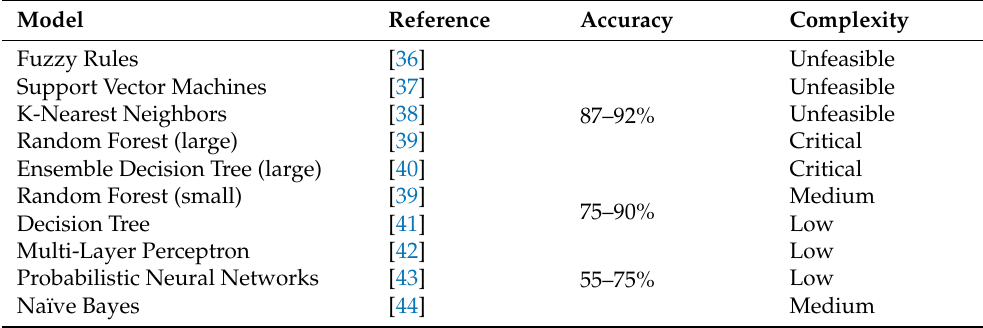
Table 2. Model evaluation algorithms with the related accuracy (percentage of correctly classified 10-min time windows) and complexity of application (computational and memory requirements).